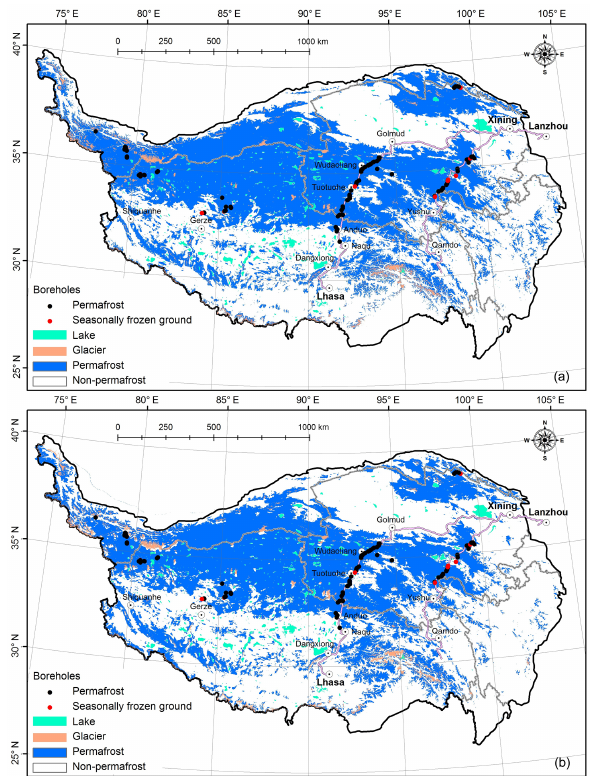
Figure 5. Comparison of the permafrost extent between the re- sults of this study (a) and the permafrost map presented by Zou et al. (2017) (b)